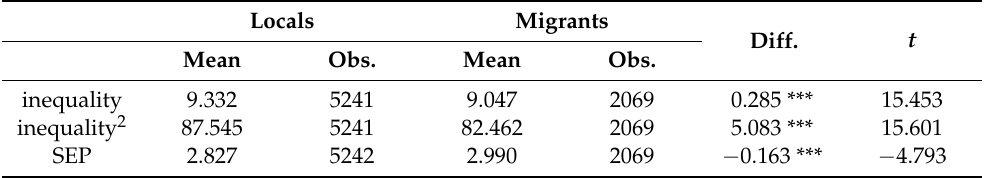
Table 8. t test of individual-level income inequality and subjective environmental pollution: differ- ences between the locals and migrants. Locals Migrants Diff. t Mean Obs. Mean Obs. inequality 9.332 5241 9.047 2069 0.285 *** 15.453 inequality 2 87.545 5241 82.462